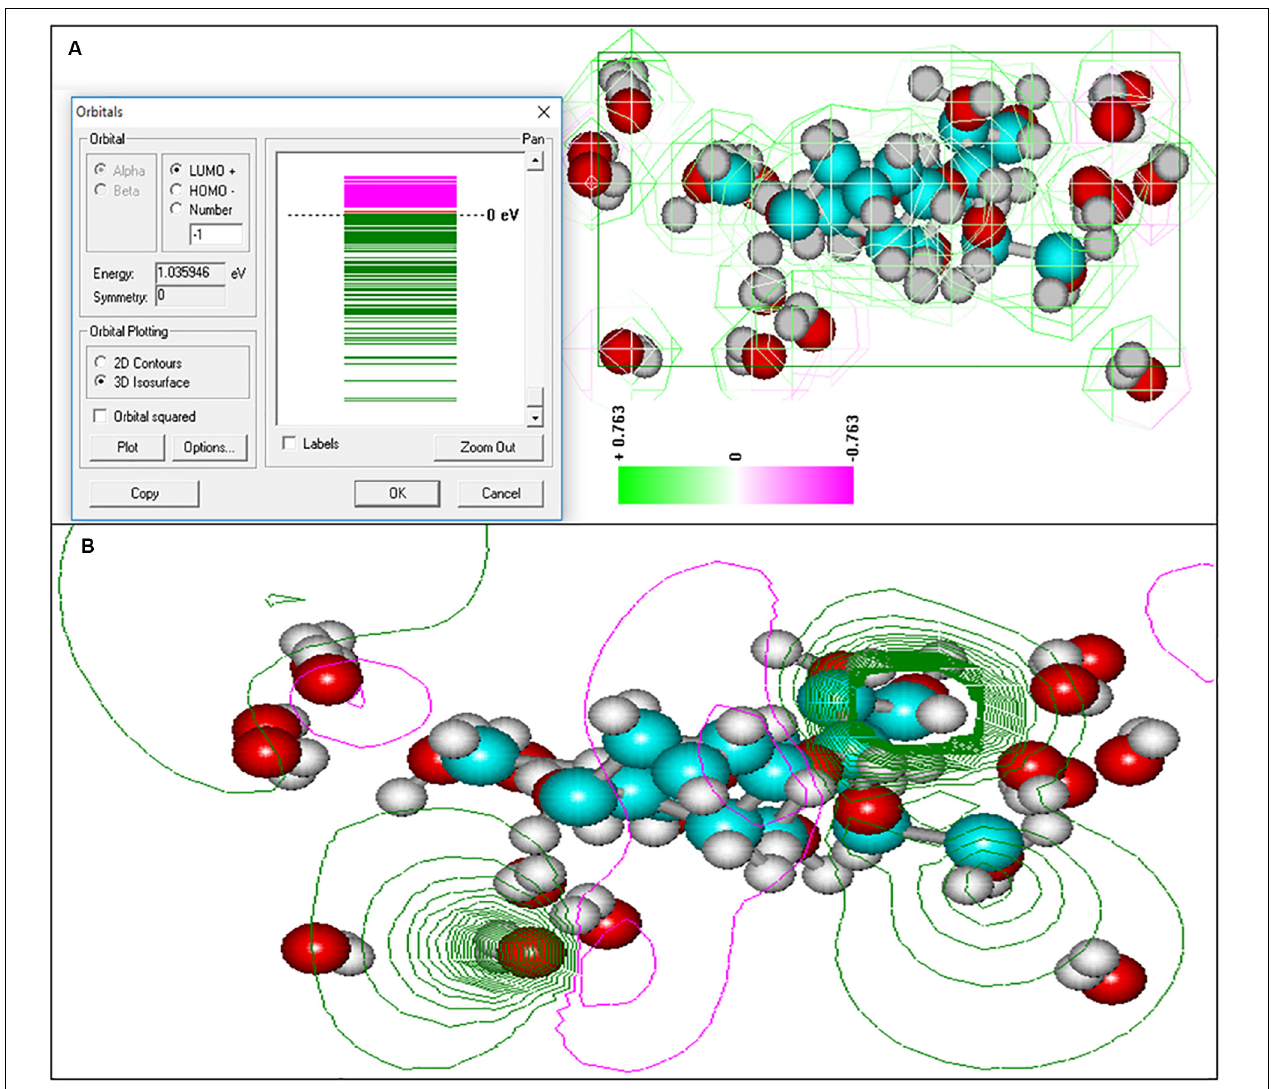
FIGURE 8 | Electronic spectra of oligosaccharide and equipotential of the surfaces of colloidal formation of At. ferrooxidans Ksh obtained by semi-empirical quantum modeling with 3D option (A) , 2D option (B) .